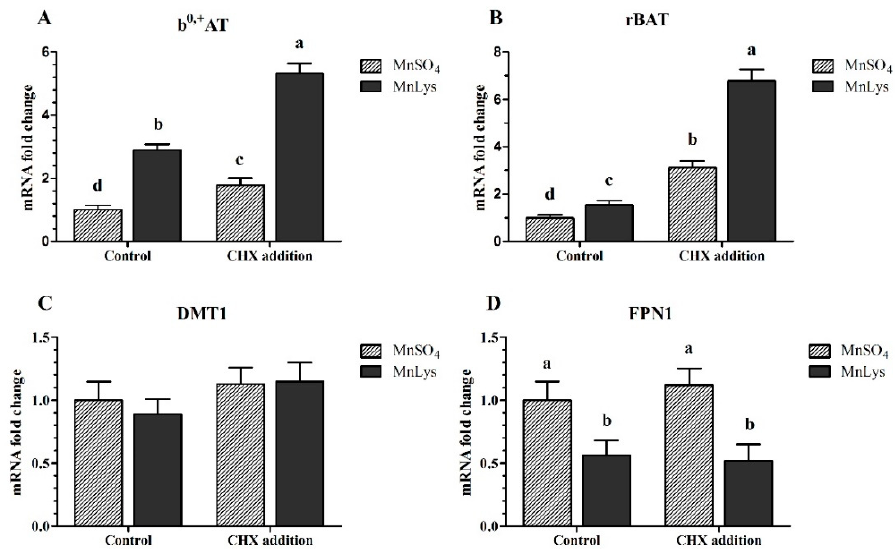
Figure 6. Influences of cycloheximide (CHX) and Mn source treatments on the membrane transporters genes expression in the primary chicken intestinal epithelial cells (IECs). The primary confluent IECs were pretreated with 10 µ M CHX for 10 min and then were incubated with 0.25 mM Mn as MnSO 4 or Mn-lysine complex (MnLys) for 60 min in the presence of CHX. The mRNA abundance of transport system b 0, + components rBAT and b 0, + AT, and ionized Mn transporters divalent metal transporter 1 (DMT1), and ferroportin 1 (FPN1) was determined by real-time RT-PCR. Interaction of Mn source and CHX treatment influenced rBAT and b 0, + AT expression but only the Mn source a ff ected the FPN1 mRNA abundance ( p < 0.05). Values are least-square means ± standard error ( n = 8). a–d Mean values lacking a common letter are different at p < 0.05.